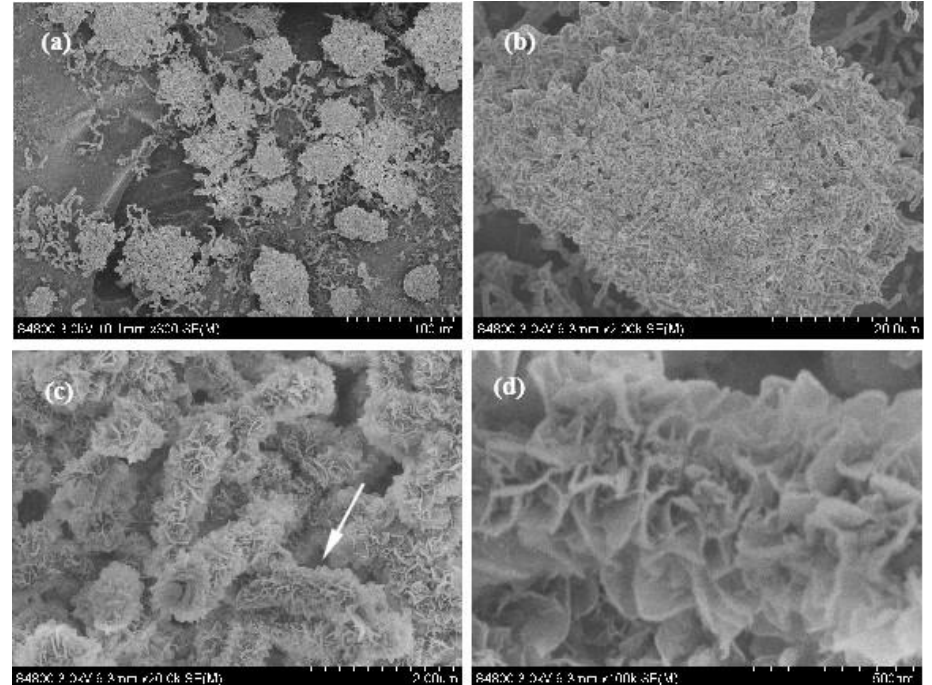
Figure 4. SEM image of the product with different magnification. ( a ) Low-magnification SEM image of the product; ( b ) SEM image of a single cluster; ( c ) enlarged SEM image of the cluster shown in ( b ); ( d ) Enlarged SEM image of single fibrous substances indicated by an arrow in ( c ). Figure 5a is the TEM image of the coral-like BN micro-/nanostructure. It can be found